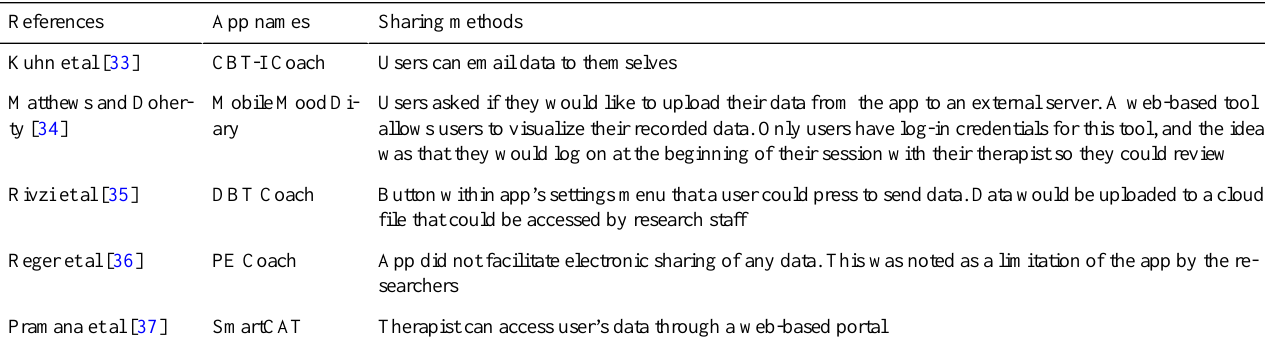
Table 2. Review of existing apps’sharing strategies.